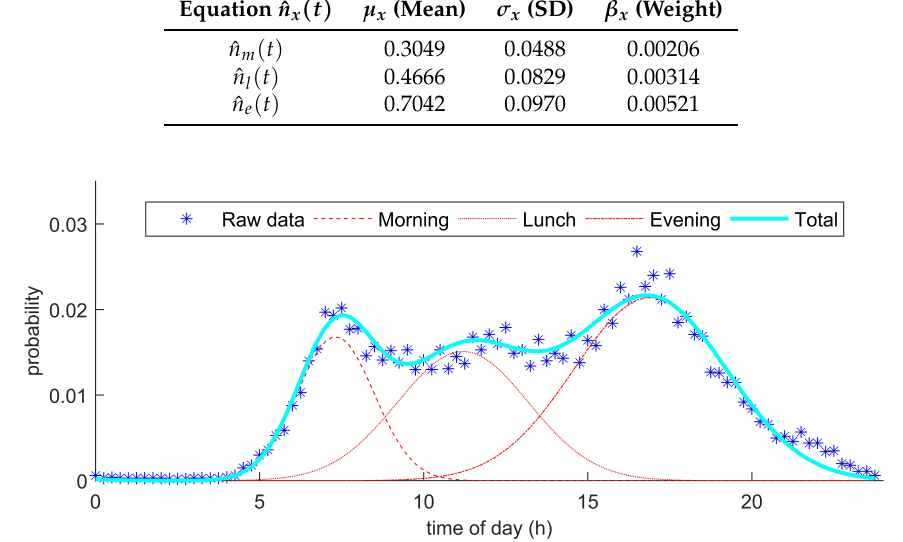
Figure 1. The probability of starting a trip at a particular time during a weekday, extrapolated into three normal distributions (RMS error: